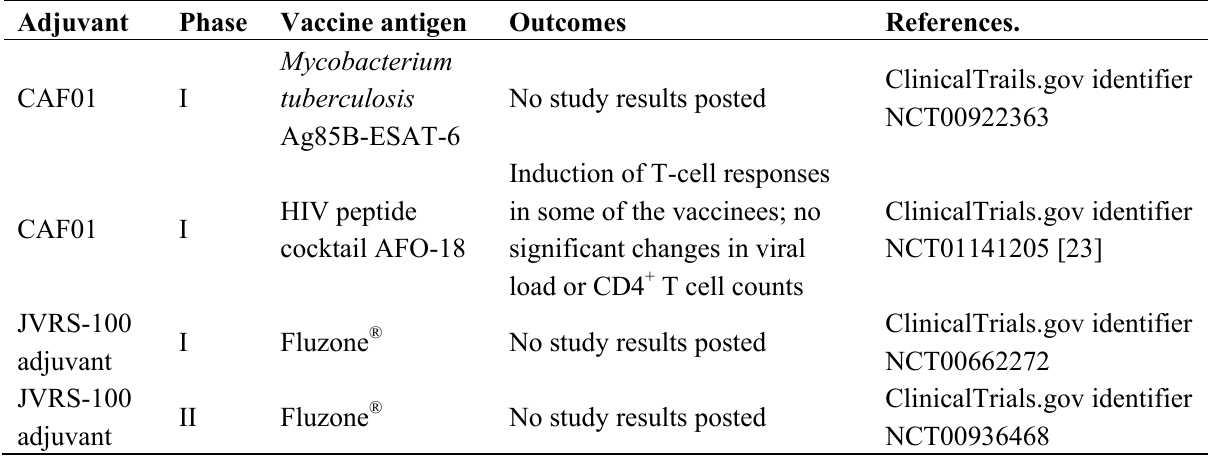
Table 1. Liposomes and TLR agonists: Clinical